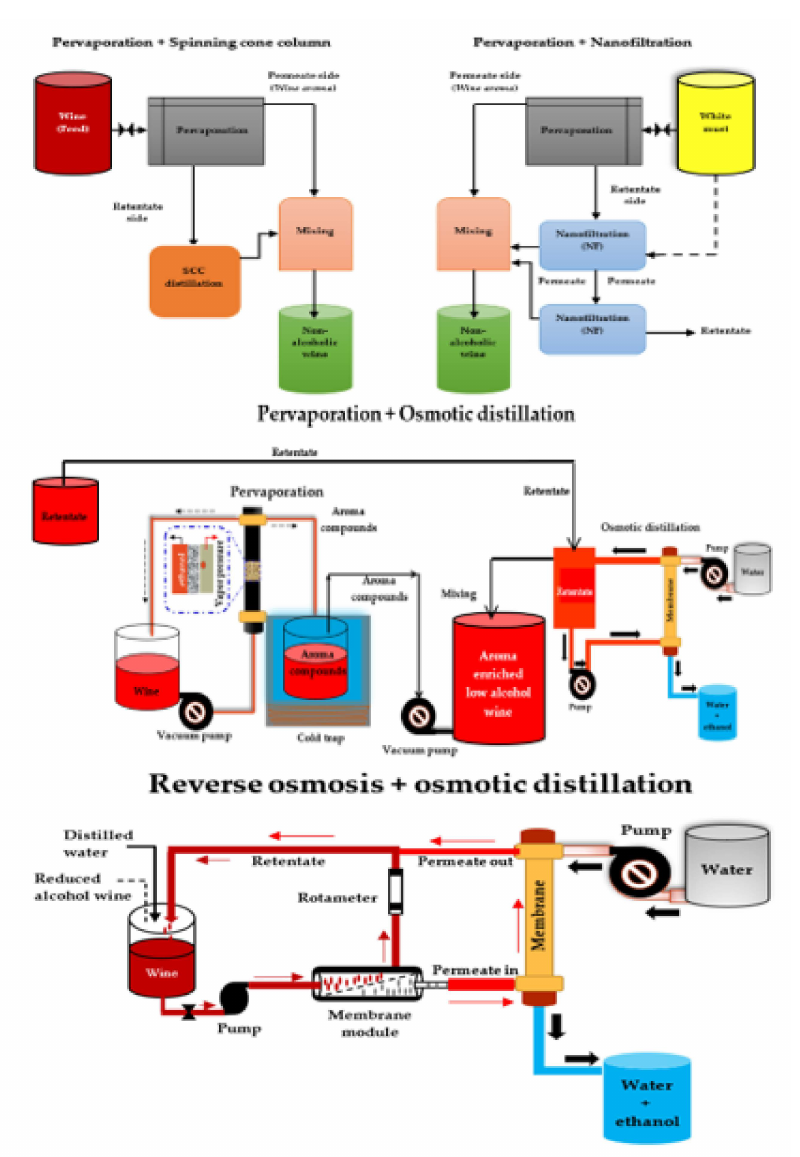
Figure 3. Scheme of different multi-stage membrane-based systems for wine dealcoholization. Adapted from Garc í a-Mart í n et al. [74], Liguori et al. [152], and Belisario-S á nchez et al.